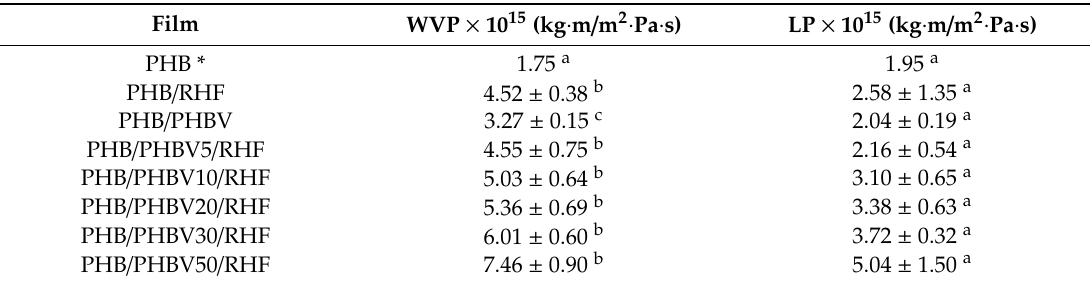
Table 6. Water vapor permeability (WVP) and d -limonene permeability (LP) of the thermo-compressed films made of poly(3-hydroxybutyrate) (PHB), poly(3-hydroxybutyrate- co -3-hydroxyvalerate) (PHBV), and rice husk flour